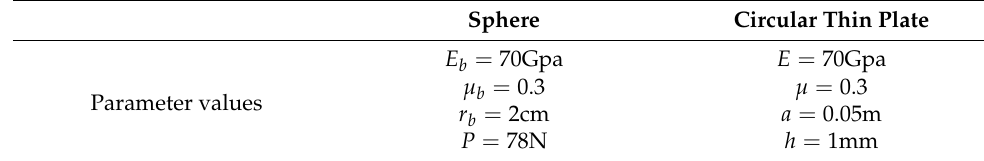
Table 1. Parameters for calculation.